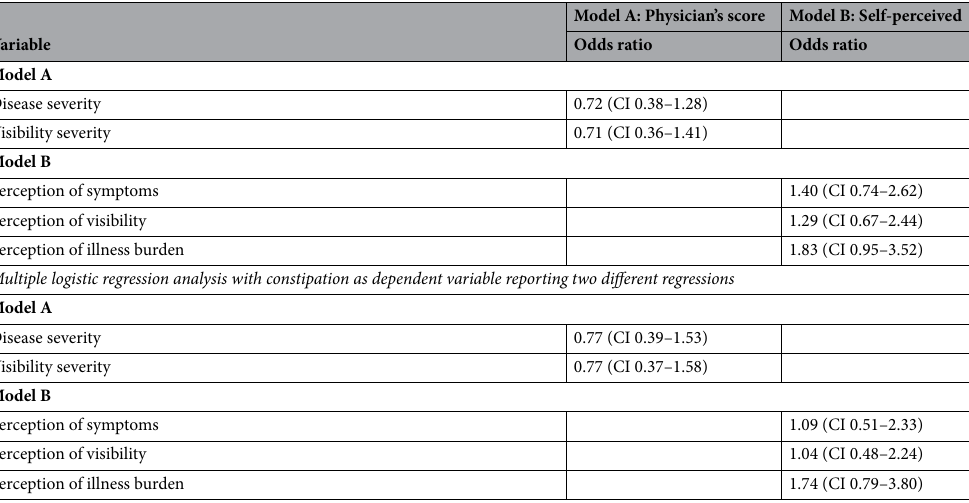
Table 3. Simple logistic regression analysis at individual level with constipation as dependent variable. CI 95% Confidence